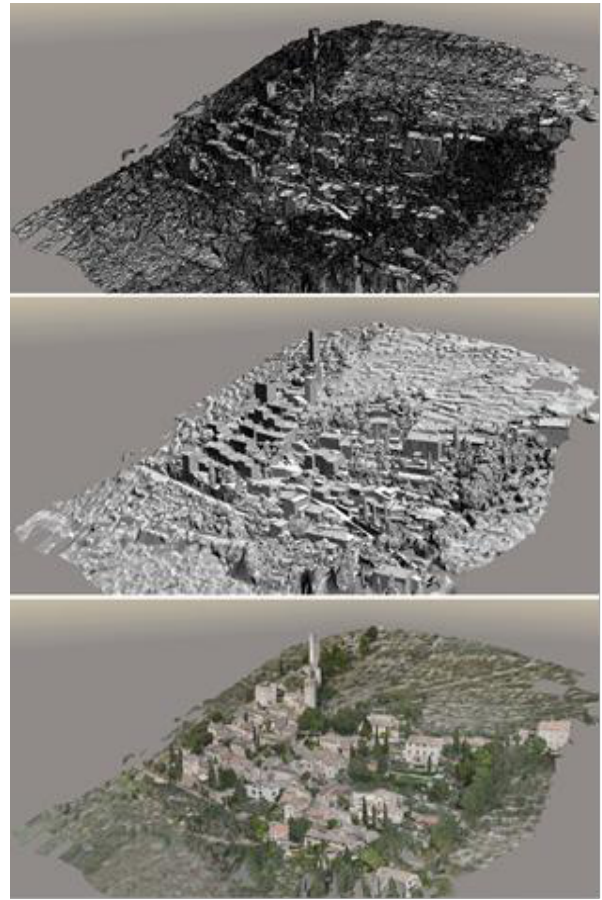
Figure 6. Texturized Mesh obtained through Context Capture To create more data from a different point of view and with different detail, a laser scanner (Faro Imager 5010) within the survey workflow and the summer school integrated the workshop for data alignment and processing. Along the streets of the village with this instrument, the Faro Scene software carried out, oriented and aligned 20 scans. Each scan contains from 20 to 30 million points coloured through the camera integrating the scanner.